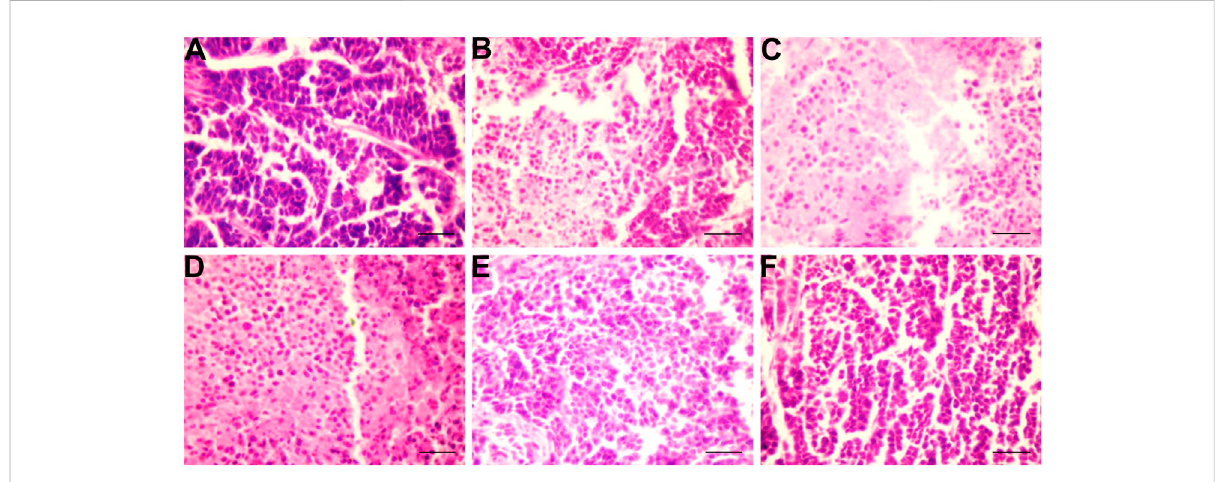
FIGURE 3 EffectsofSFA/matrine+5-FUonpathologicalchangestotumortissueintheBGC-823-transplantednudemice.SectionswerestainedwithH&E and viewed at a magni fi cation of ×400. Scale bar = 50 μ m. (A) Model control (negative control). (B) 5-FU control (0.01 g/kg) (positive control). (C) SFAD (0.2 g/kg)+5-FU (0.01 g/kg). (D) Matrine (4.03 mmoL/L)+5-FU (0.01 g/kg). (E) SFAD (0.2 g/kg). (F) Matrine (4.03 mmoL/L).